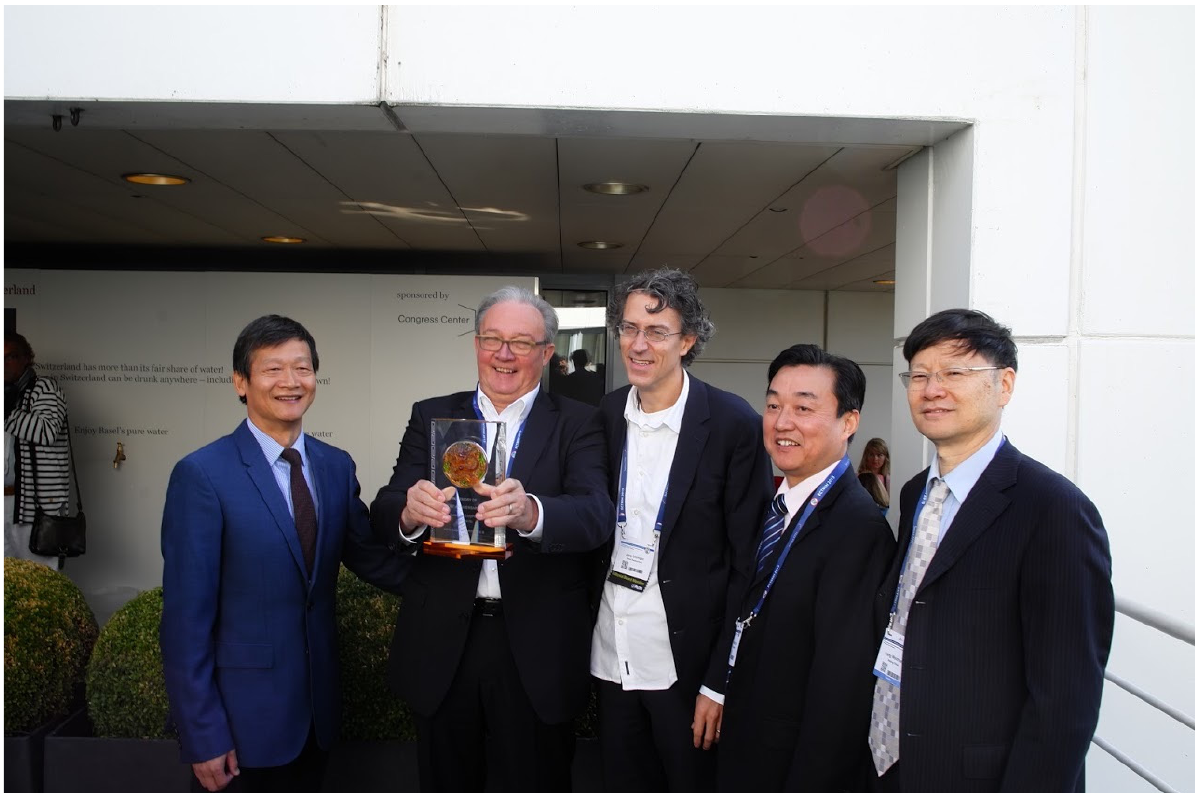
Figure 5. Professor Tanner with the award of Excellent Advisor to celebrate his 20th anniversary of cooperation between NIPD and Swiss TPH, presented by Professor Zhou on behalf of NIPD at the Swiss TPH in Basel, Switzerland, in 2015. From left: Dr Jiagang Guo, Professor Marcel Tanner, Pro- fessor Jürg Utzinger, Professor Xiao-Nong Zhou, Professor Wei-Zhong Yang. In his meeting with the delegation from Xinhua Co., Ltd. in January 2013, Professor Tanner used the old adage: “if you want to go fast, walk alone; if you want to go far, walk together”. We believe that this is a good summary of how the successes were reached over the last 30 plus years, through collaboration over borders. Not only does it ensure that there is a road ahead, it also underlines that the collaboration initiated by Professor Tanner and his Chinese colleagues can continue, and indeed be strengthened, by the young gen- eration now coming of